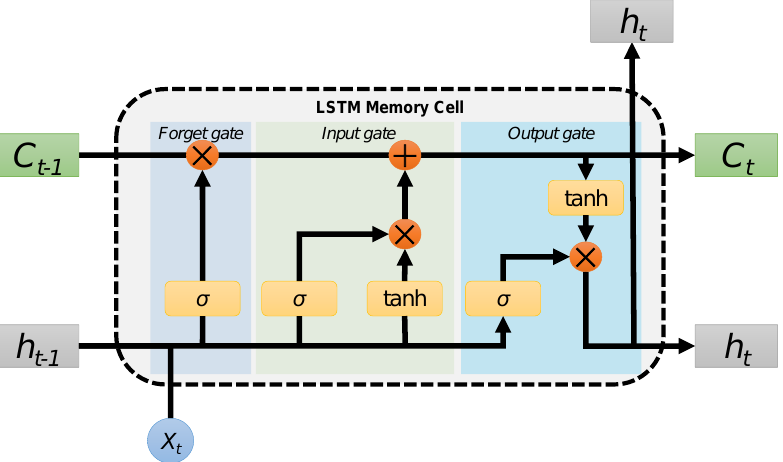
Figure 2. The architecture of Long Short Term Memory (LSTM)